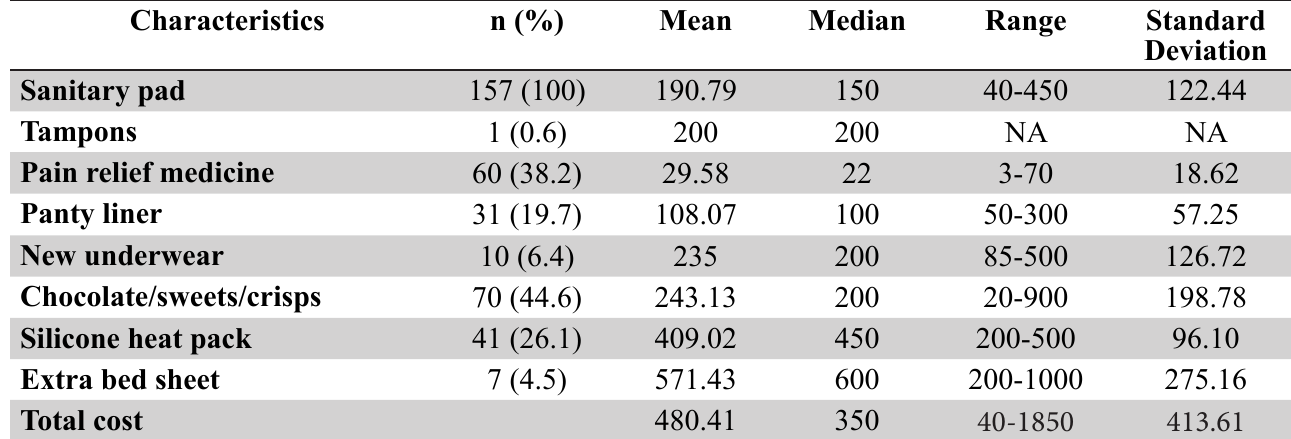
Table 2: Cost (NPR) of different items used in last menstrual period (N=157).